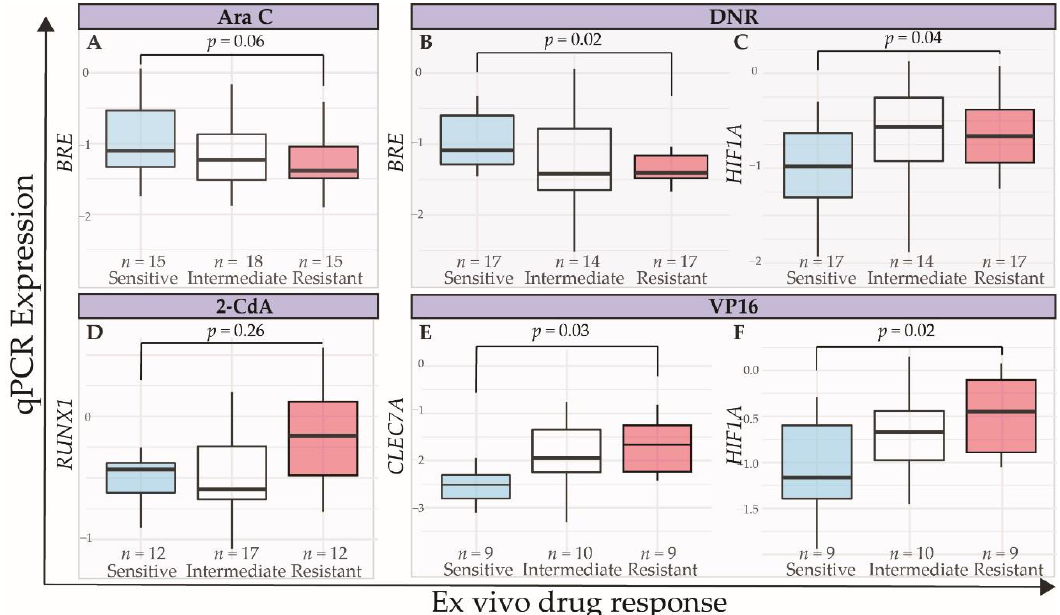
Figure 7. Independent validation of expression levels measured by qPCR of selected genes in samples of 48 pediatric AML patients. Expression levels of BRE in sensitive (light blue), intermediate (white), and resistant (red) patient samples, based on 30th and 70th percentile towards ( A ) Ara C and ( B ) DNR. ( C ) Expression levels of HIF1A , according to response to DNR. ( D ) Expression levels of RUNX1 , according to response to 2-CdA. ( E ) Expression levels of CLEC7A and ( F ) HIF1A , according to the response to VP16. p -values were calculated using Wilcoxon Rank Sum test.